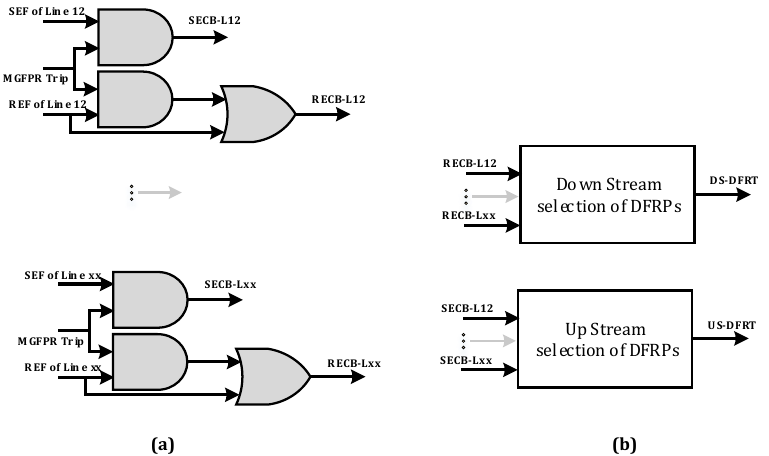
Figure 4. The proposed external protection scheme for DGUs. ( a ) sending-end and receiving-end protection commands, and ( b ) upstream and downstream command selection for DGU external command purposes.